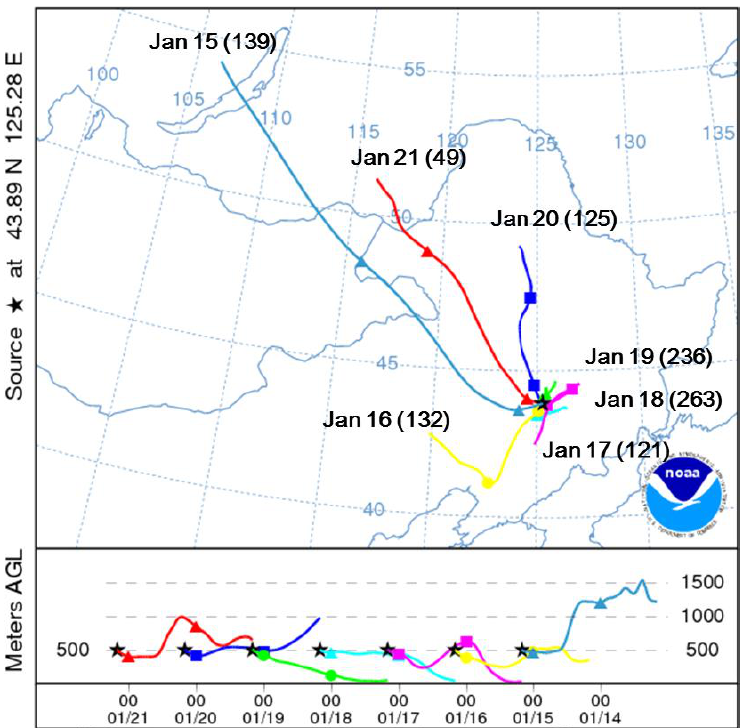
Figure 3. The evolution of 48-h backward trajectories commencing at 12:00 (local time) on 15 through 21 January 2012 at Changchun (43.89 N, 125.28 E) during which a haze event occurred on 18 and 19 January. The evolution of the trajectories is indicated by dates at the ends of the trajectories. The numbers in the brackets are PM 2.5 mass concentrations at the S4 site for each day. The black lines in the lower panel are the terrain heights where the trajectories passed over.